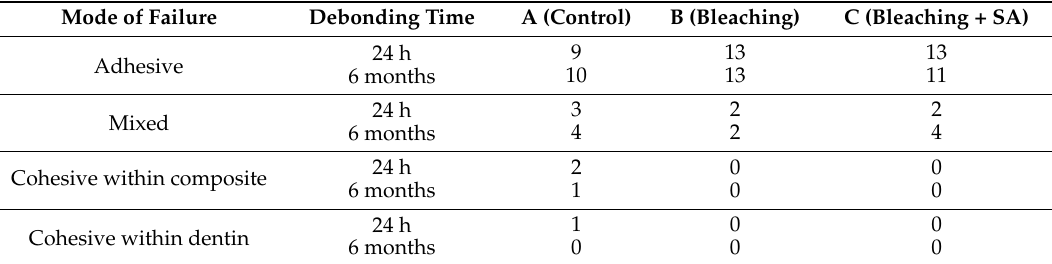
Table 2. Distribution of failure mode in experimental groups.